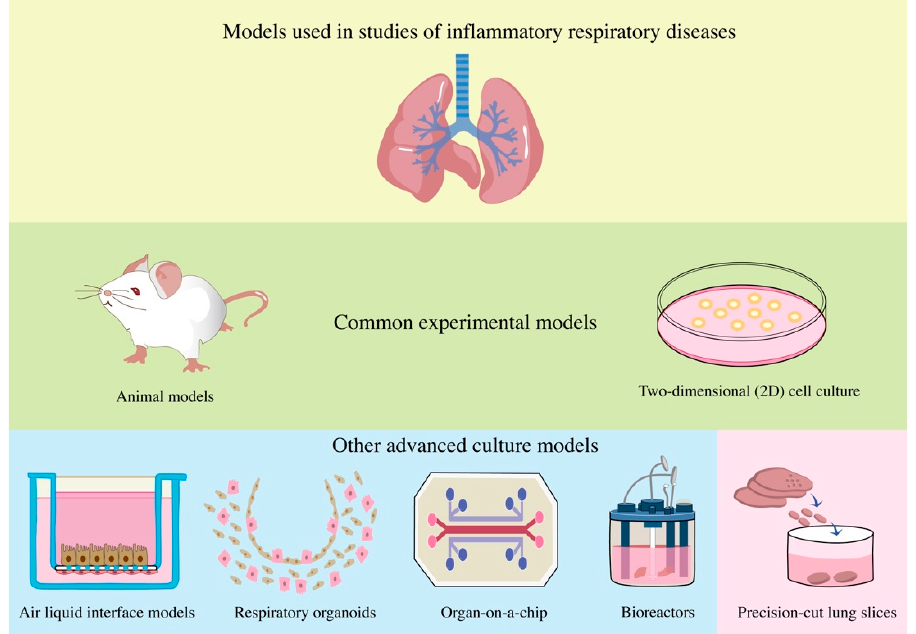
Figure 1. Traditional animal models and 2D cell culture are the common experimental models in studies of inflammatory respiratory diseases. In other advanced culture models, the ALI model can fully reproduce the differentiation of human natural gas tract epithelium with exposure to pathogenic factors in vitro. “Respiratory organoids” can be isolated and amplified from different regions of the mouse and human lungs and then inoculated into 3D cultures to form self-organization. Organ-on-a-chip consists of the air-blood chamber and the attached vacuum channel, which simulates the movement changes of the lung through the stretching of the PDMS membrane and simulates lung function at the organ level. Bioreactors can be seen as vessels for in vitro or ex vivo studies and for the growth of cell and tissue systems, which are more physiologically relevant than traditional static in vitro models. Precision-cut lung slices are thin and uniform 3D lung slices made from human or animal lung tissues. They can reduce the cellular structure and ECM in the native lung environment well while preserving the interaction between different cell types and the ECM.